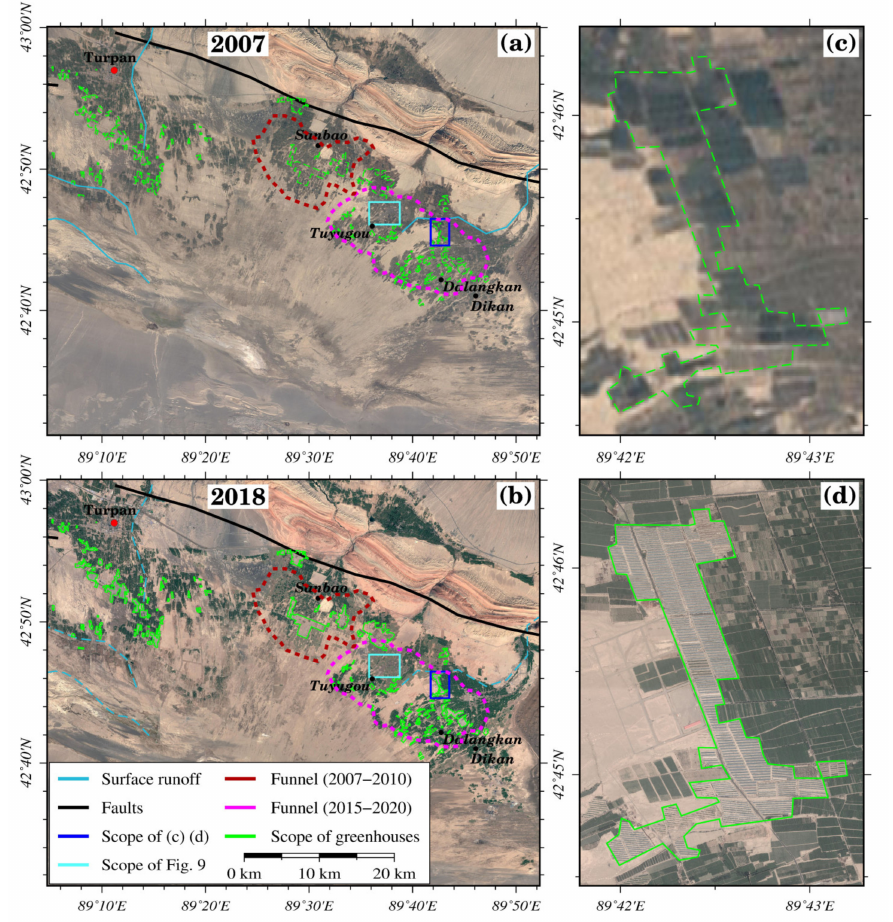
Figure 8. ( a , b ) Optical images of the SFM–def region in 2007 and 2018. Green lines delineate greenhouse planting areas. ( c , d ) Zoom-ins of the blue rectangular area in ( a , b ) in 2007 and 2018. Background image: Google Maps satellite